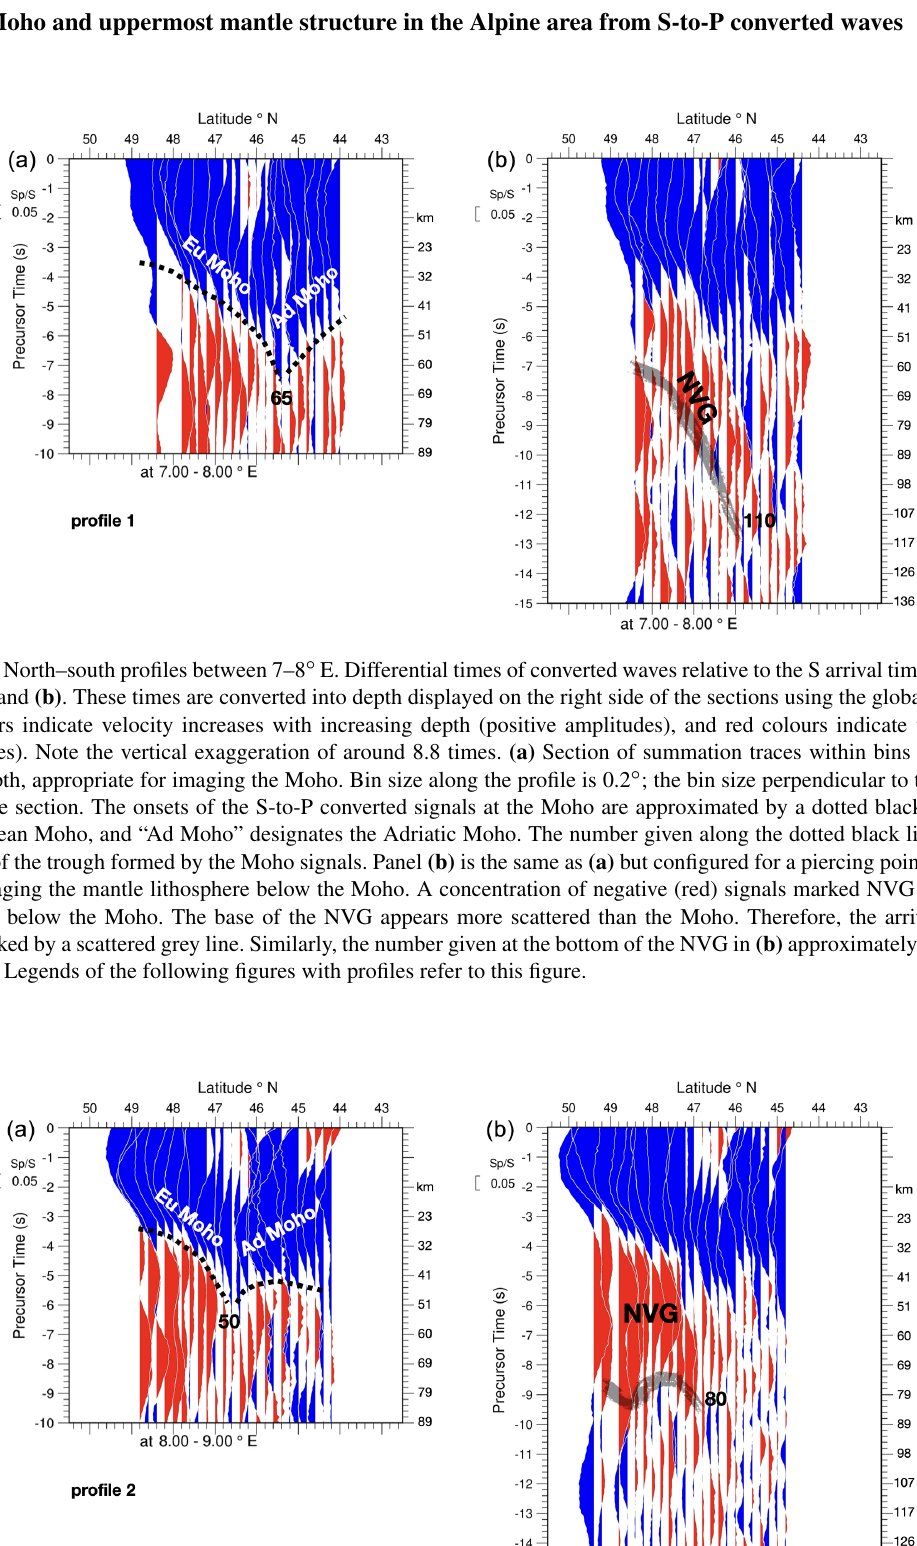
https://doi.org/10.5194/se-12-2503-2021 Solid Earth, 12, 2503–2521,